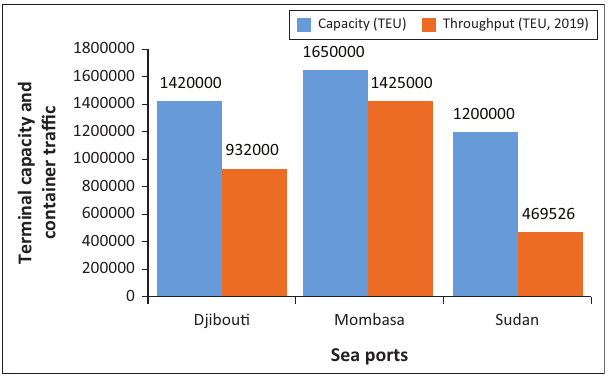
FIGURE 4: (a) Port charges for containers/20-foot equivalent units and (b) stevedoring and shore-handling charges for dry bulk per ton.